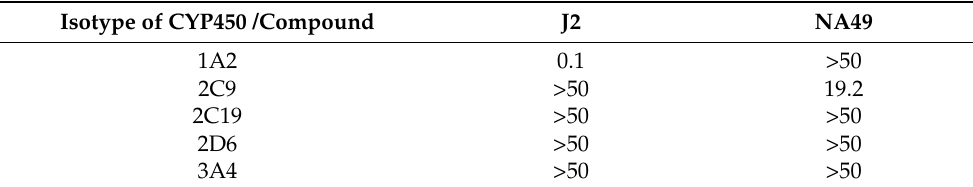
Table 3. IC 50 ( µ M) values a of J2 and NA49 against isotypes of CYP450 enzyme. Isotype of CYP450